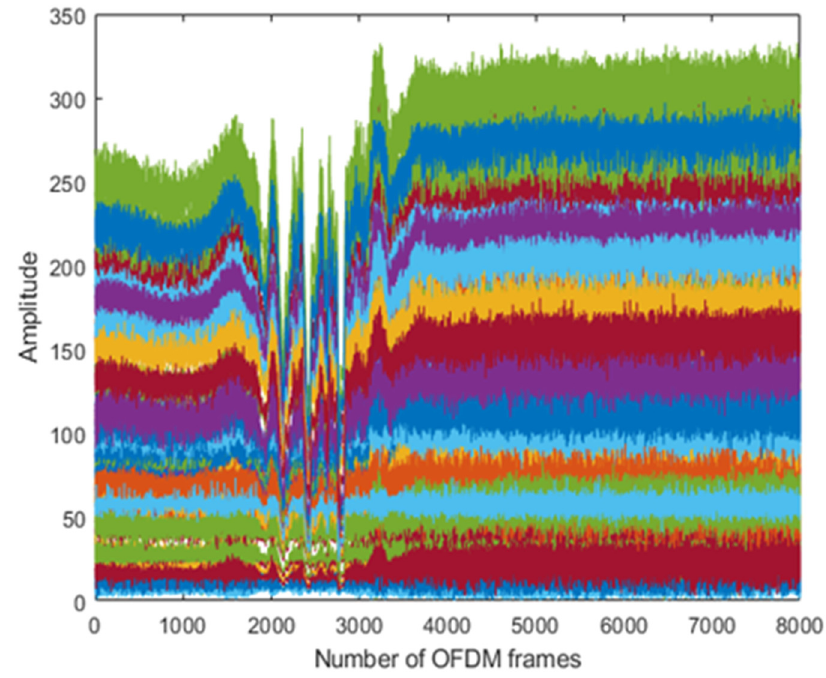
Figure 6. WCSI amplitude response of bending activity experiment.